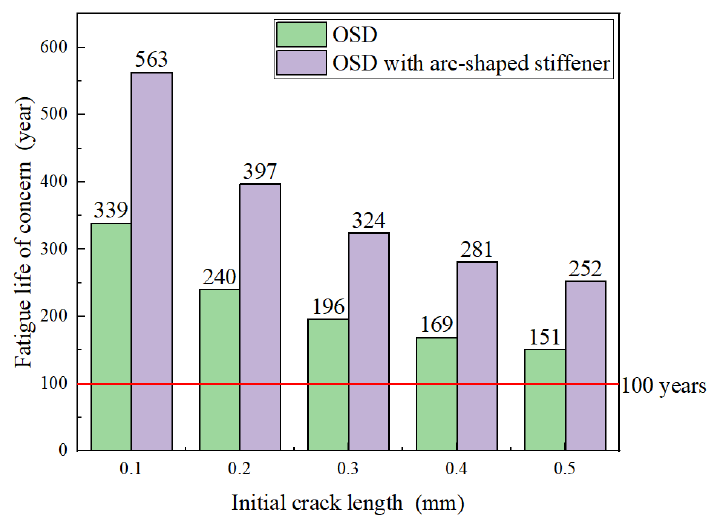
Figure 11. Fatigue life evaluation.